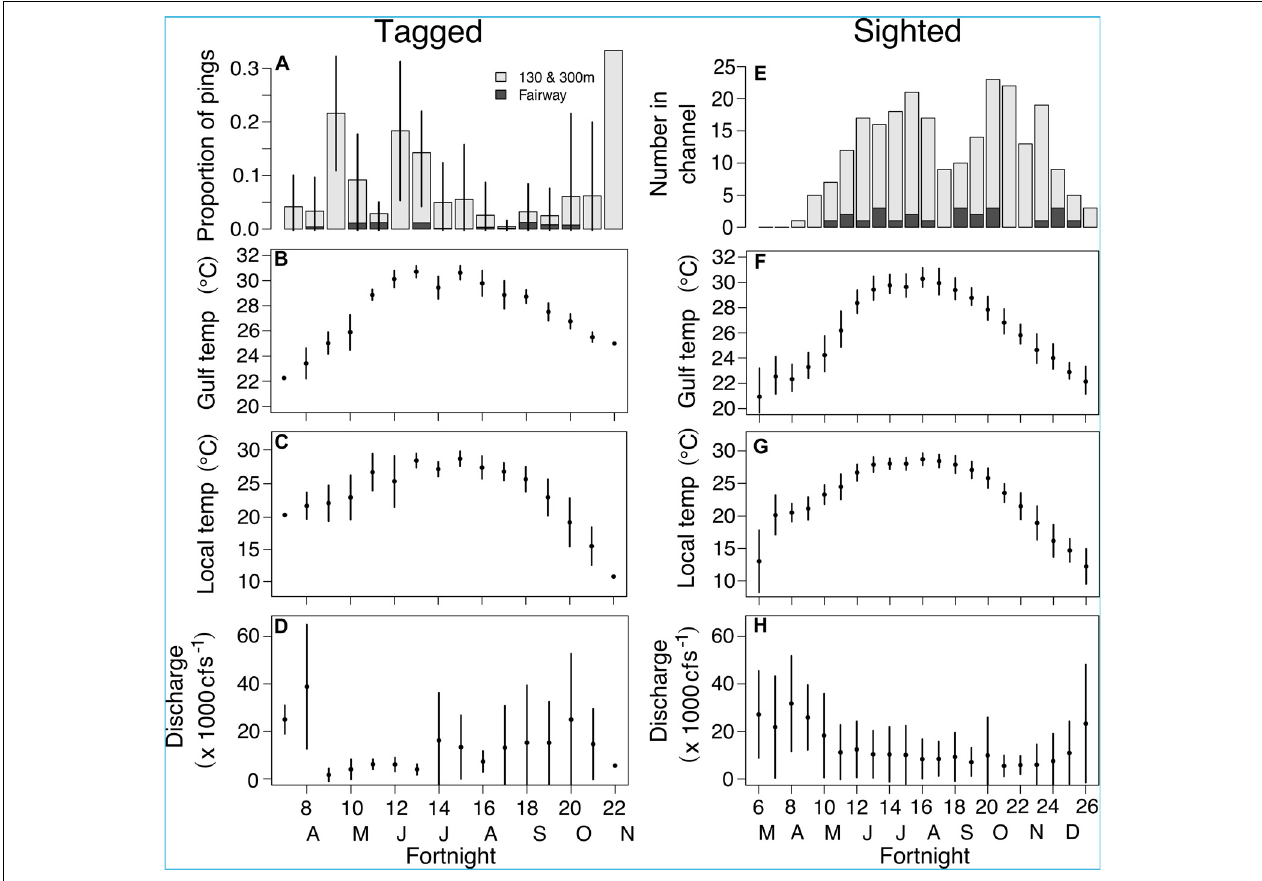
FIGURE 3 | The average proportion of GPS pings ( ± SD) from tagged manatees (left column) in ship channels per fortnight period (A) and the sum of sighted manatees (right column) per fortnight period (E) . The average ( ± SD) nGoM water temperature (B,F) , local air temperature (C,G) , and freshwater discharge of the nearest river (D,H) per fortnight for the periods of time that manatees were detected or sighted in ship